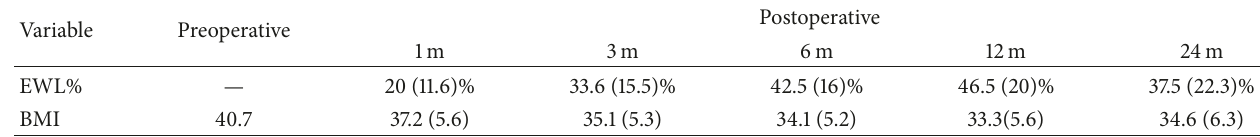
Table 1: Weight loss variables: BMI and EWL% at 1, 3, 6, 12, and 24 months postoperatively.